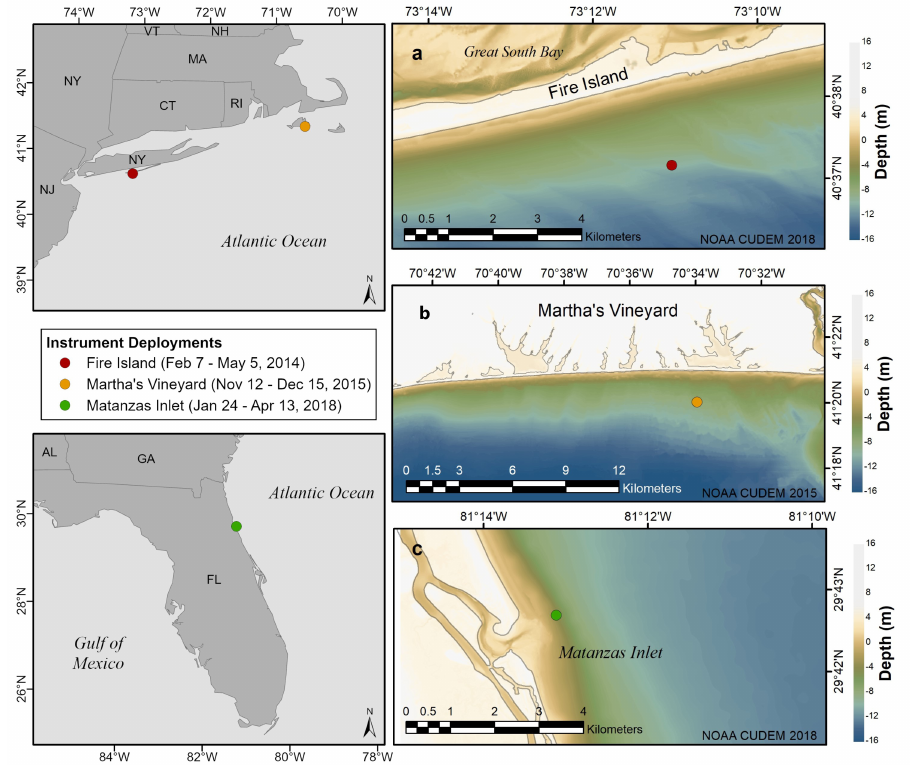
Figure 1. Study sites: ( a ) Fire Island, New York, ( b ) Martha’s Vineyard, Massachusetts, ( c ) Matanzas Inlet,